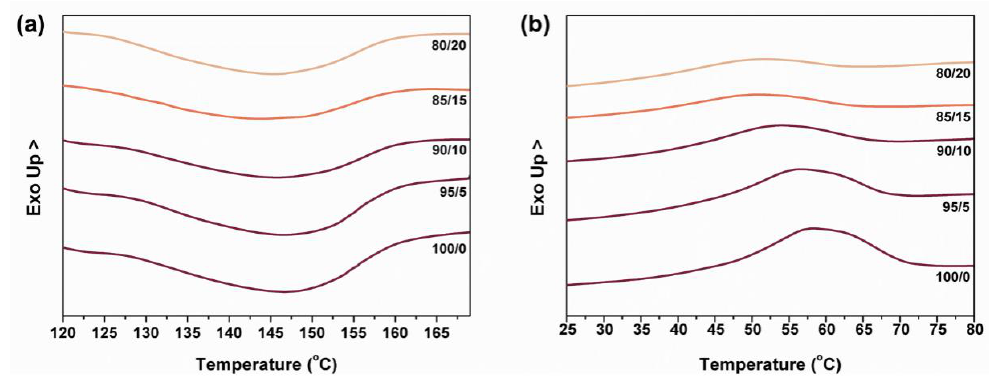
Figure 4. DSC curves of ( a ) melting and ( b ) crystallization of TPU composite films.